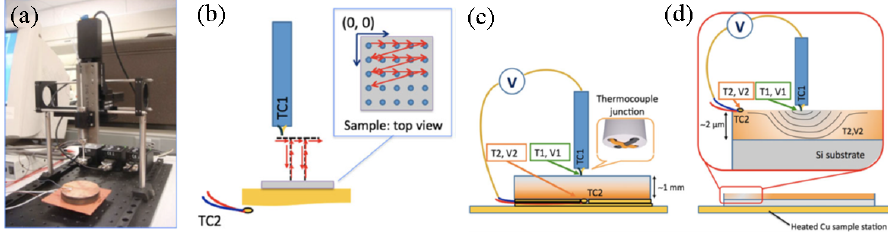
Figure 5. ( a ) Photograph of the scanning Seebeck coefficient measurement system and ( b ) schematic illustration of the scanning tip routes; Schematic illustration of the setup for ( c ) bulk and ( d ) thin-film samples. Reproduced from [100] with permission; Copyright Springer 2012.